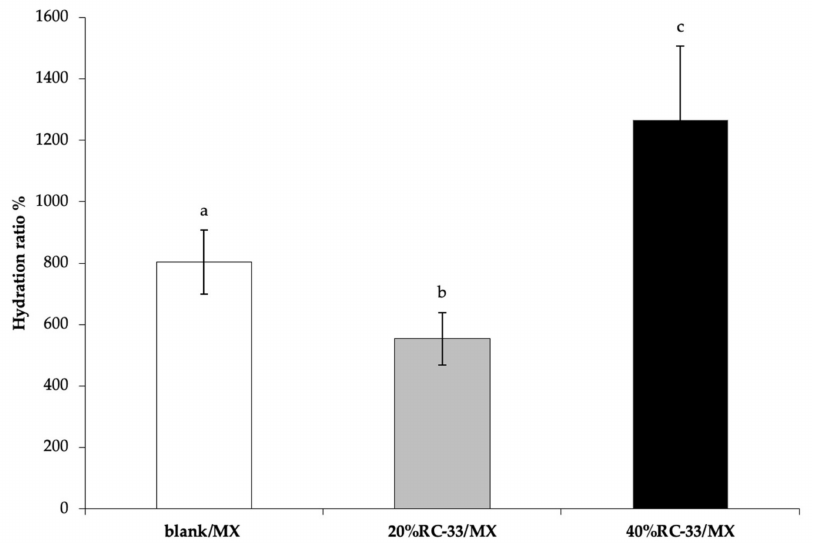
Figure 8. Hydration ratio % values of MXs loaded with RC-33 amounts corresponding to 20 and 40% of the GG interaction sites (respectively, 20%RC-33/MX and 40%RC-33/MX); blank/MX was used as reference (mean values ± s.e.; n = 3). One-way ANOVA; post hoc Scheff é test ( p ≤ 0.05): b vs.